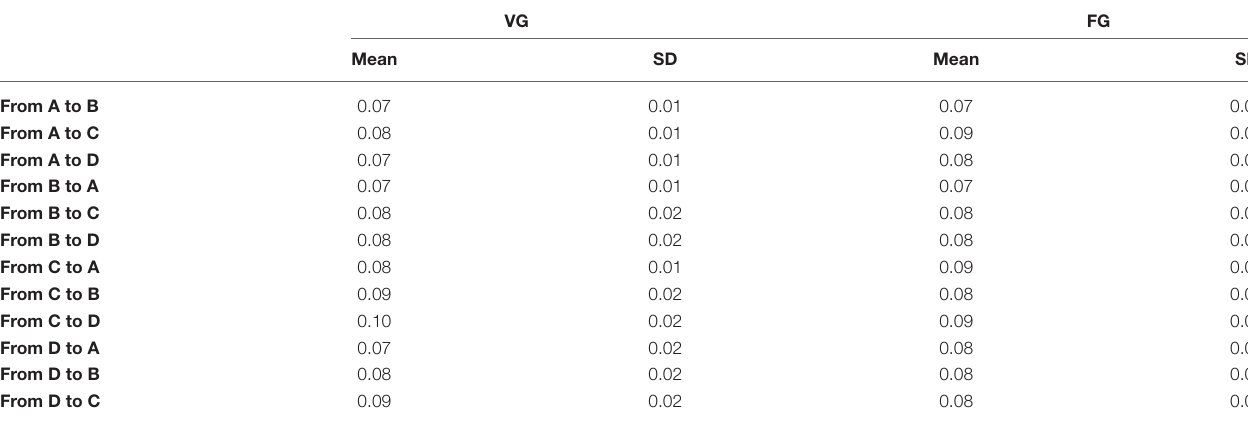
TABLE 3 | The means and standard deviation (SD) of transition probability between any two microstate